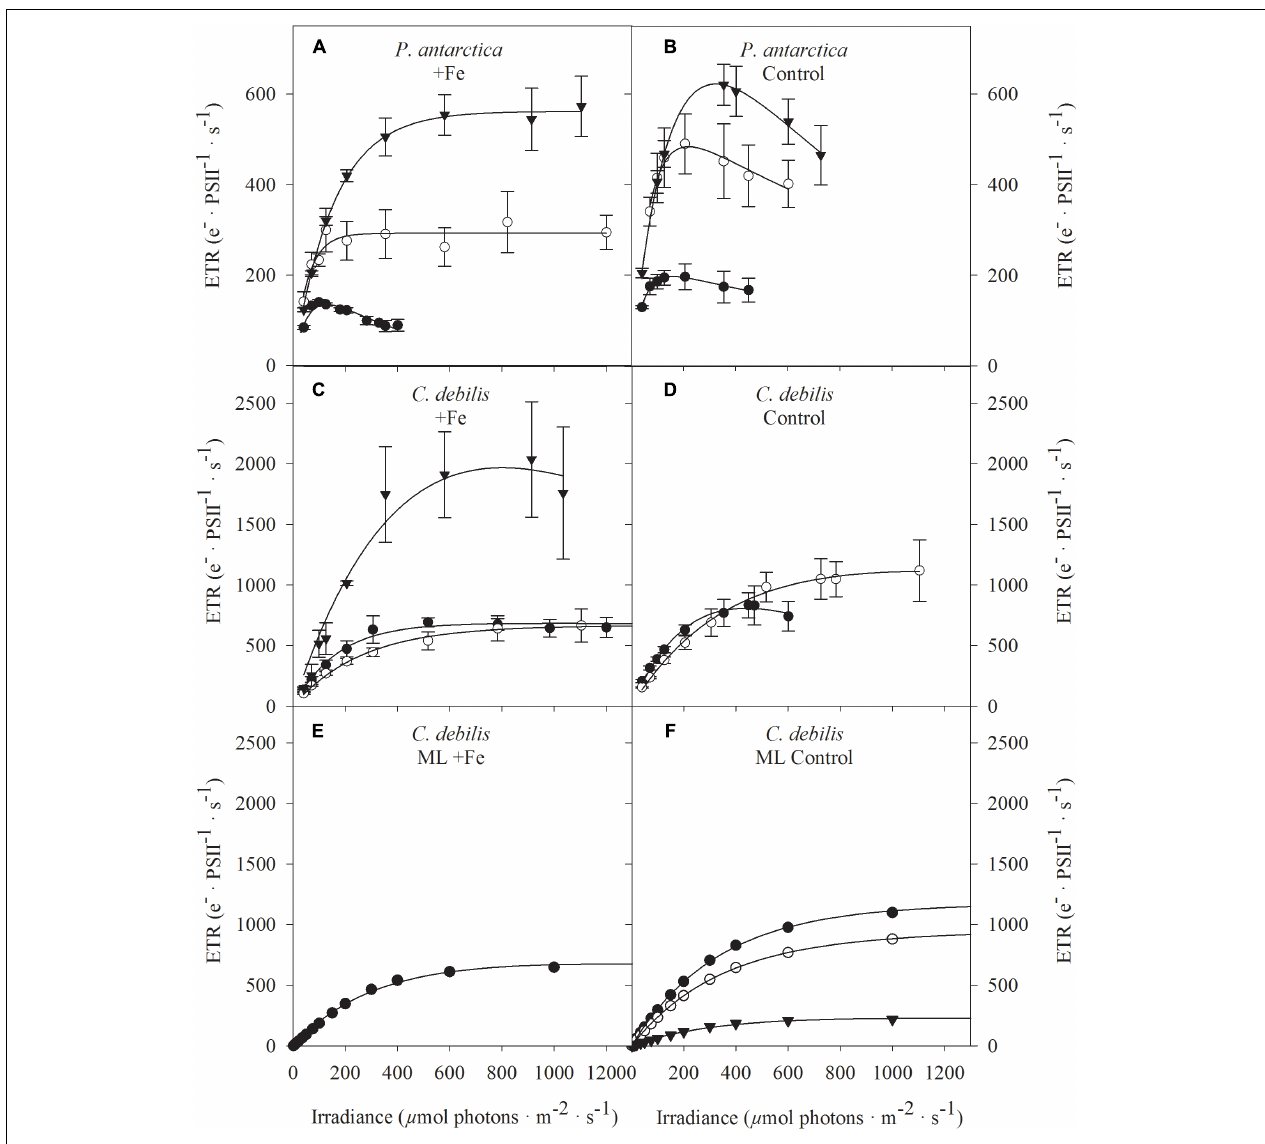
FIGURE 3 | Absolute electron transport rates (ETR) were measured in response to increasing irradiance in (A,B) P. antarctica and (C,D) C. debilis acclimated to Fe-enriched (A,C) and control (B,D) conditions combined with low (LL, filled circles), medium (ML, open circles) and high (HL, triangles) light. ETRs were obtained in three individual measurements. Values represent the means ± SD ( n = 3). Different letters indicate significant differences between treatments ( p < 0.05). Using the model of Kroon and Thoms (2006), which was adapted to diatoms, total absolute ETRs (filled circles) were calculated by the example of ML acclimated C. debilis cells, which were grown under Fe-enriched (E) or control (F) conditions. The simulations are based on antenna scenarios and the amount of oxidized plastoquinone (PQ) as described in detail in Supplementary Table S2 . In panel F, also the contribution of linear (triangles) versus putative plastid plastoquinol terminal oxidase (PTOX) activity (open circles) relative to the total ETRs is